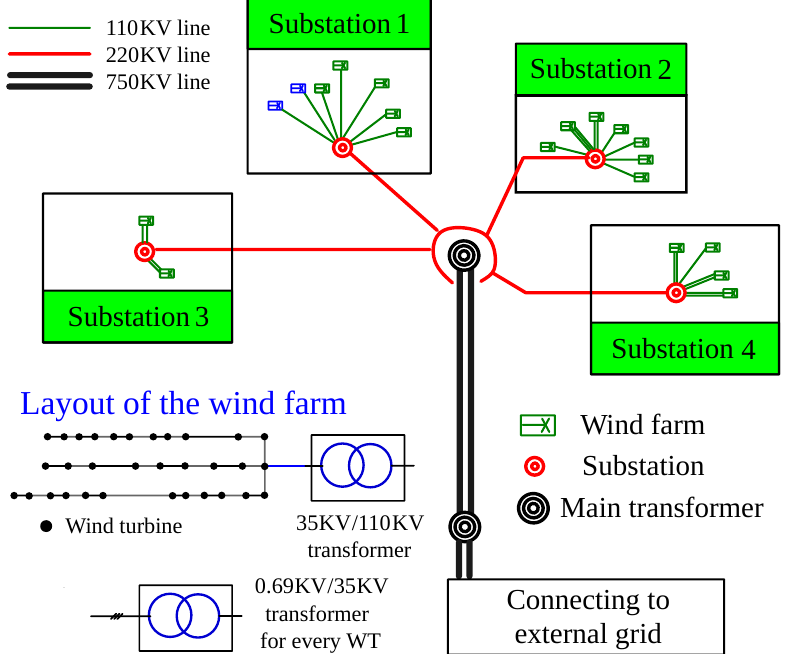
Figure 1. System topology of a wind farm. The long transmission line and lines inside wind turbine (WT) strings are not drawn